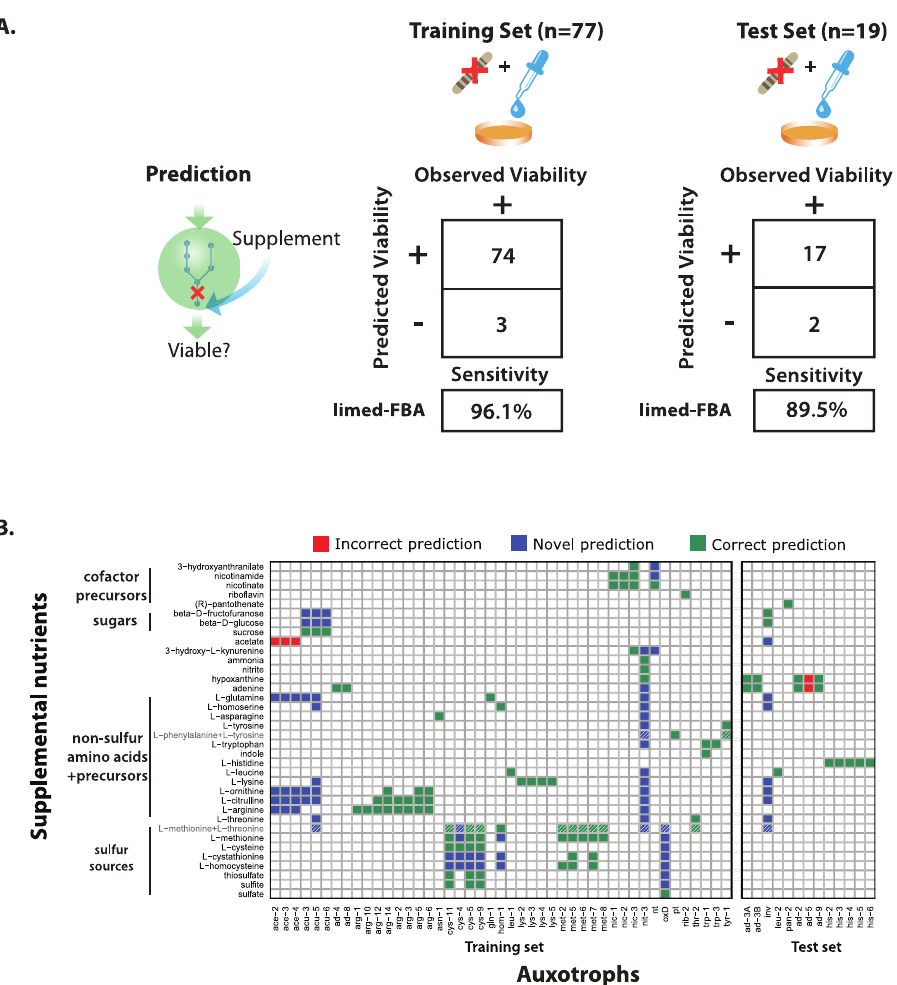
Figure 5. Prediction of nutrient rescue. We curated a collection of conditions in which an auxotroph was rescued when minimal media was supplemented with a nutrient. We separated the collection into a training set, where knowledge of the rescue phenotype was used to improve the model, and a test set, where the rescue phenotype was hidden from the model. Because we only collected data on which nutrients rescued the auxotrophs, we could only measure sensitivity, not specificity. (A) Tables showing the sensitivity of limed-FBA predictions on nutrient rescue training and test sets. (B) Heatmap showing the growth phenotype of each mutant when minimal media is supplemented with each nutrient used in the training and test sets. Only mutants whose minimal media gene essentiality was correctly predicted are included. The minimal media used was Vogel’s with sucrose as the carbon source except in the following cases: acu-3,5,6 genes are essential when acetate is the sole carbon source; oxD is essential when D-methionine is the sole sulfur source; nit-3 is essential when nitrate is the sole nitrogen source. Green squares indicate that the model’s predictions were consistent with experiment; red squares indicate that the model failed to correctly predict growth; blue squares indicate potentially novel rescues; white squares indicate predictions of non-rescue. Striped squares show that the multi-substrate case does not contain additional information beyond the single-substrate case, e.g. methionine is predicted to rescue the cys-4 mutant, so methionine + threonine is also predicted to rescue cys-4